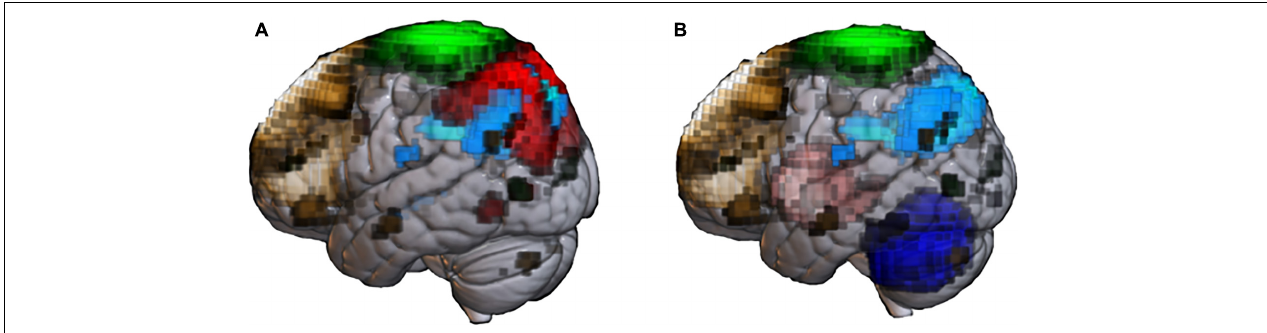
FIGURE 1 | Abnormal resting-state networks in Alzheimer’s disease (AD) and Parkinson’s disease (PD). Functional network templates were extracted from the MRI database (70 healthy elderly) at the National Center of Neurology and Psychiatry’ to display network abnormality reported in past AD (A) and PD (B) studies. (A) Default mode network (DMN, light blue) is the representative network impaired in patients with senile-onset AD. Early- onset AD shows impaired not only DMN, but also executive control network (brown), sensory-motor network (SMN, green) and dorsal-attention network (red). (B) Patients with PD shows extensive network impairment, including basal ganglia (pink), cerebellum network (blue), and SMN. PD patients with cognitive impairment shows impaired DMN and ECN.